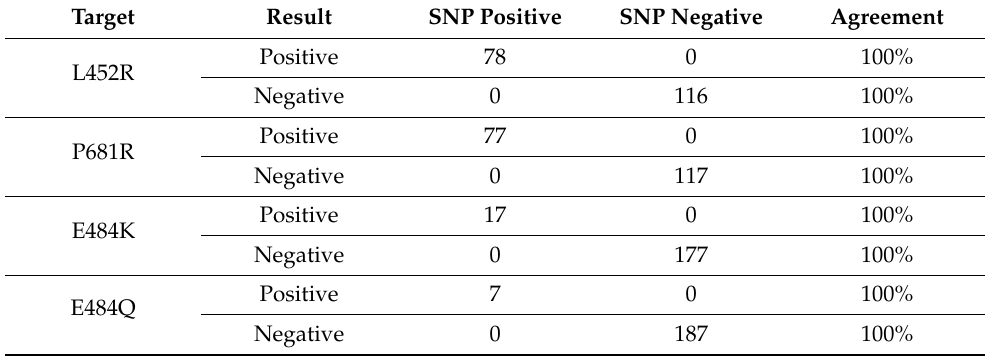
Table 5. Clinical samples (UTM or guanidine thiocyanide) were subjected to testing on the multiplex- screening-assay. Results are analyzed for each target SNP individually. A complete list of the involved SARS-CoV-2 lineages can be found in Table 4. The total number of SARS-CoV-2 RNA positive samples was